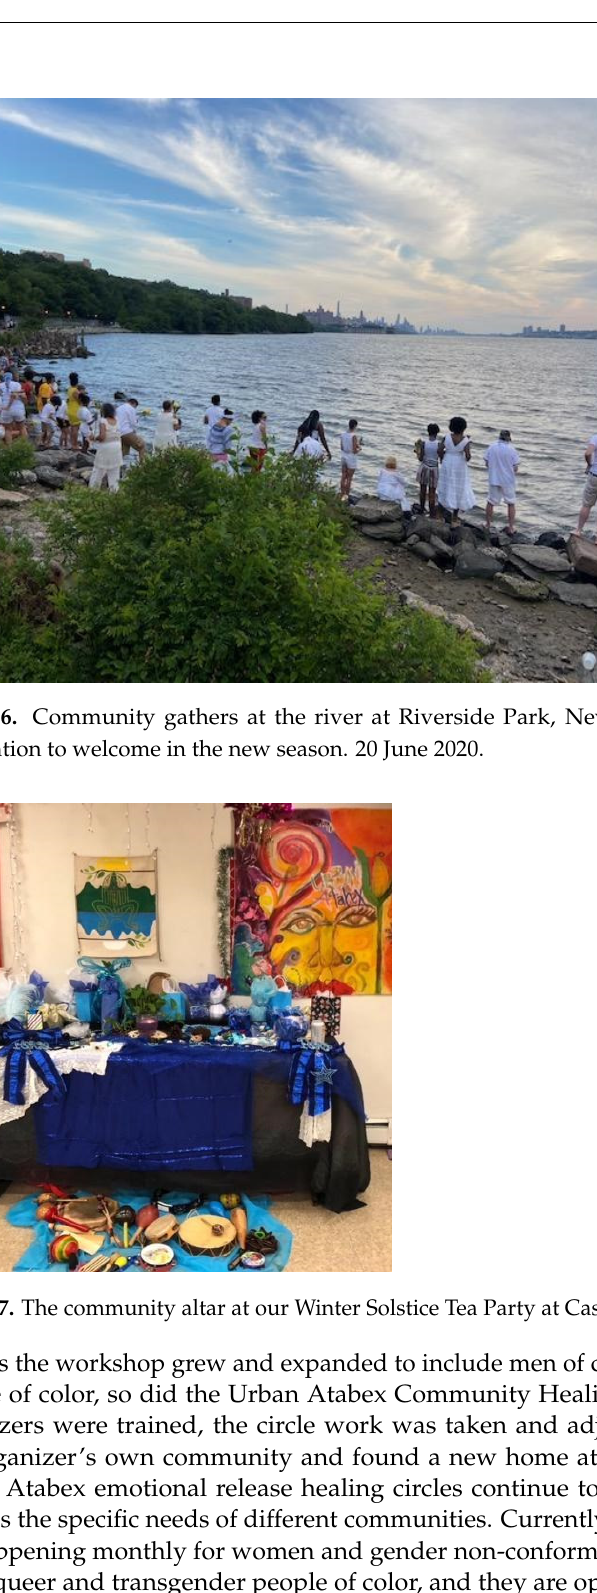
Figure 5. Urban Atabex community at National Day of Mourning at Plymouth Massachusetts. 22